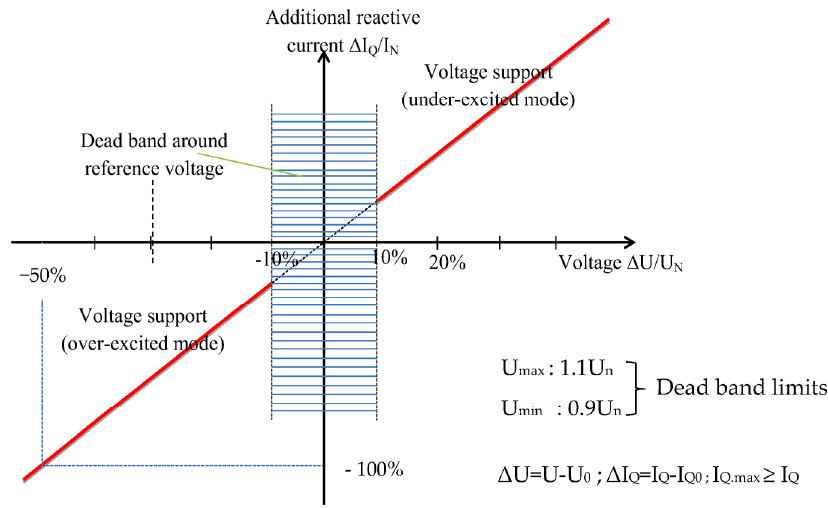
Figure 7. The concept of voltage control during voltage perturbations according to the E. ON grid code [23].